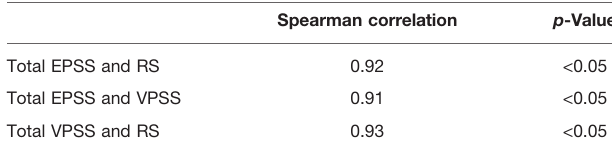
TABLE 4 | Spearman ’ s correlation of total score between VPSS, EPSS, and